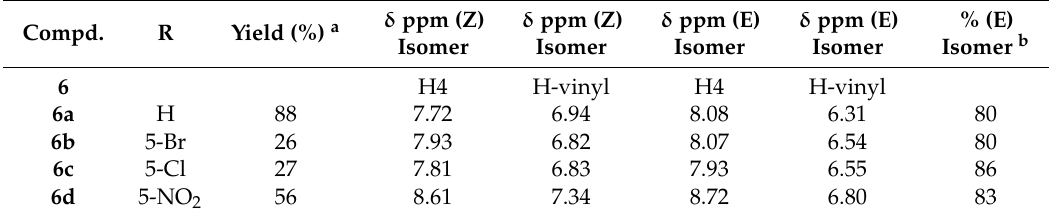
Table 4. Yield of conversion of dithiazole ( 3a – 3d ) into 2-(2-oxindolil-3-ylidene)acetonitriles ( 6a – 6d ) with two equivalents of supported triphenylphosphine. Compd.